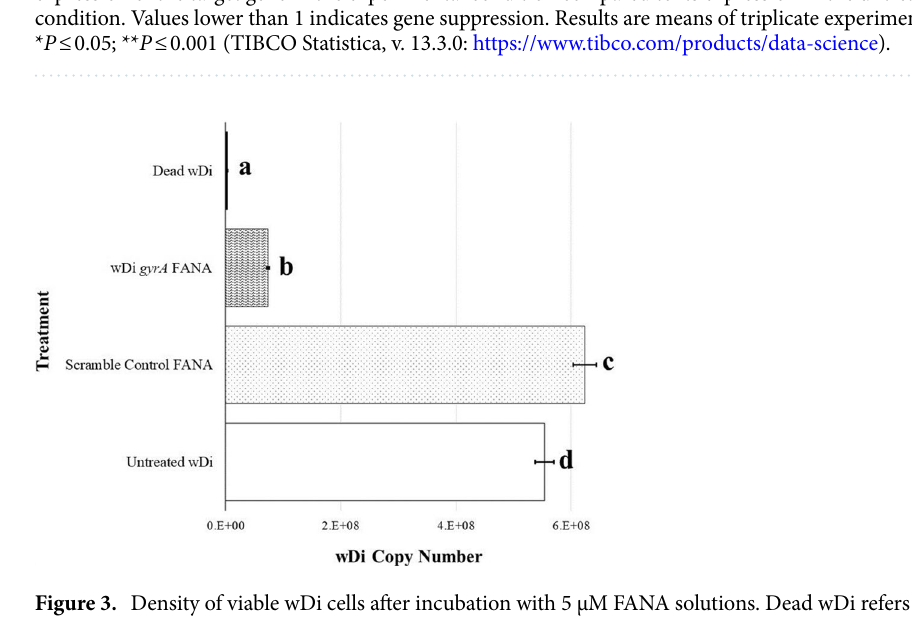
Figure 3. Density of viable wDi cells after incubation with 5 µM FANA solutions. Dead wDi refers to bacterial cells that were incubated at 95 °C for 10 min. Statistical differences between the treatments ( P ≤ 0.05) are designated by different letters (ANOVA: F (3, 8) = 614.35; P ≤ 0.0001). Results are means of triplicate experiments ± SE (TIBCO Statistica, v. 13.3.0: https ://www.tibco .com/produ cts/data-scien